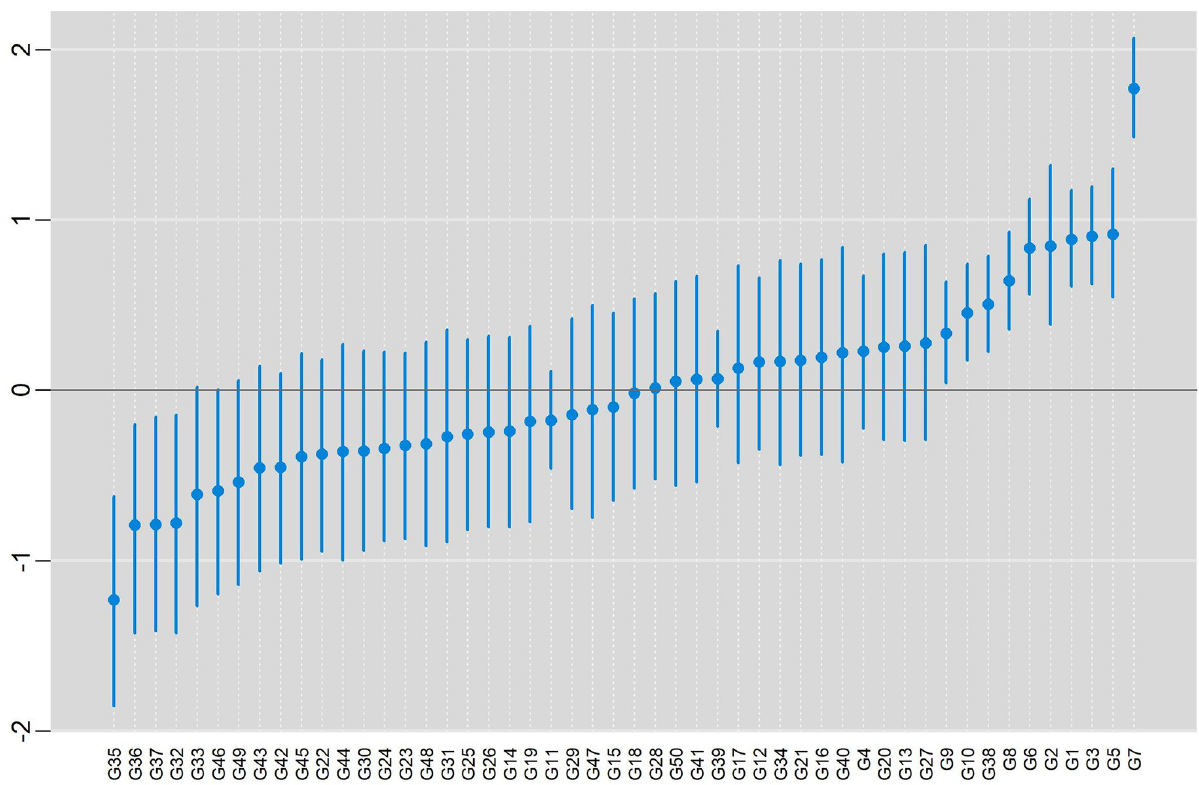
Fig 16. Posterior means and the 95% HPD intervals for the effect of genotypes, considering the BAMMIE-3 model, for real data using the MCMC method.